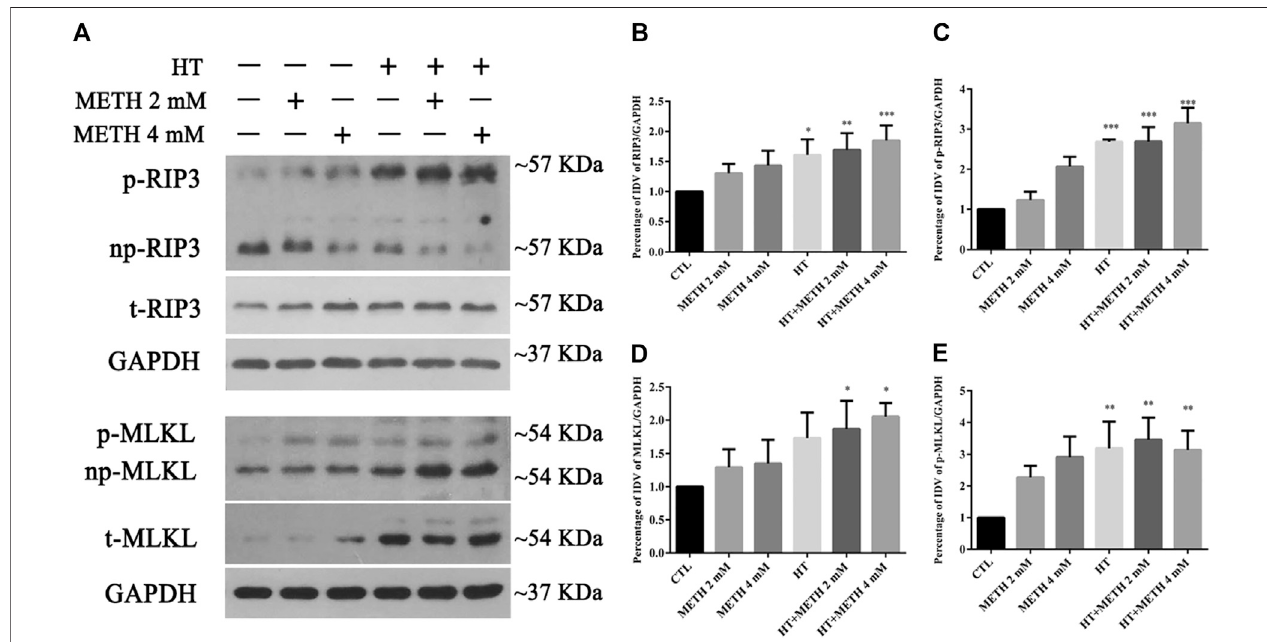
FIGURE 3 | Detection of RIP3, p-RIP3, MLKL, and p-MLKL expression by WB after METH/HT injury in striatal neurons. (A) p-RIP3, RIP3, p-MLKL, and MLKL protein levels in primary cultures of striatal neurons detected by phos-tag SDS-PAGE and WB after 6 h of METH treatment at 39.5 ° C. (B – E) Statistical analysis of WB of p-RIP3,RIP3,p-MLKL,andMLKLexpression.Datawereanalyzedbyone-wayANOVA,followedbyaTukeymultiplecomparisonsposttest( n (cid:2) 3).* p < 0.05,** p < 0.01, *** p < 0.001 vs. CTL